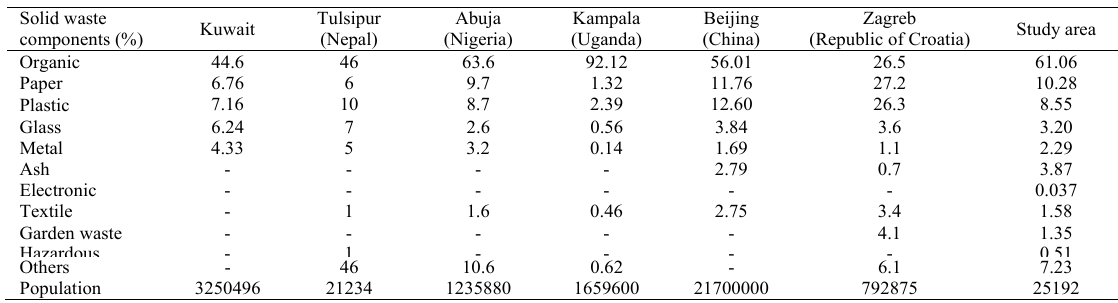
Table 5: The waste percentages of the field of study and the comparison of those percentages with other studies in the world (Al-Jarallah and Aleisa, 2014; Dangi, et al., 2013; Ogwueleka, 2013; Komakech et al., 2014; Wang and Nie, 2001; Ribic, et al., 2016) Solid waste components (%) Organic